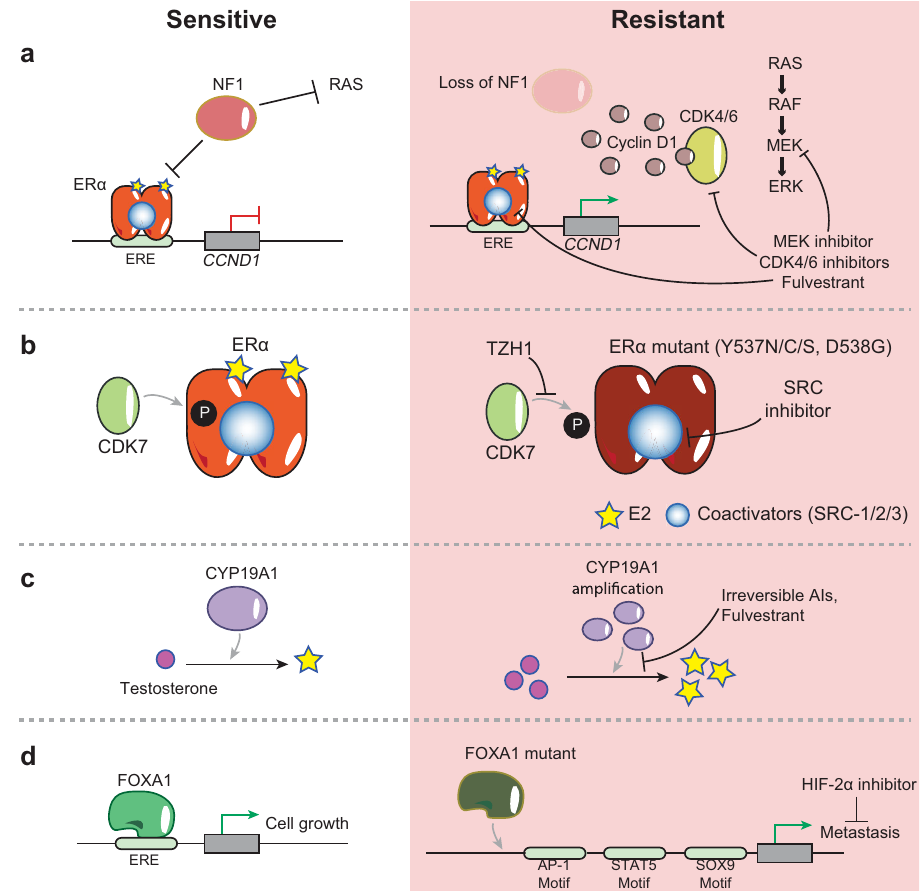
Fig. 3 Illustrations of selected genomic alterations that mediate therapeutic resistance in ER + breast cancer. a NF1 is a GTPase that (1) inhibits RAS activation of the MAPK pathway and (2) functions as a corepressor of ER α at the CCND1 gene, which encodes cyclin D1. Loss of NF1 in treatment-resistant cells results in increased activation of the MAPK signaling pathway and overexpression of cyclin D1, which promotes G1/S transition by activating CDK4/6. MEK inhibitors and CDK4/6 inhibitors can overcome MAPK and CDK4/6 overexpression, respectively. Fulvestrant can also be used in cases where there is loss of NF1 . b In treatment-sensitive ER + breast cancer, ER α dimerizes upon binding to E2 and is phosphorylated by CDK7. ESR1 mutations often occur